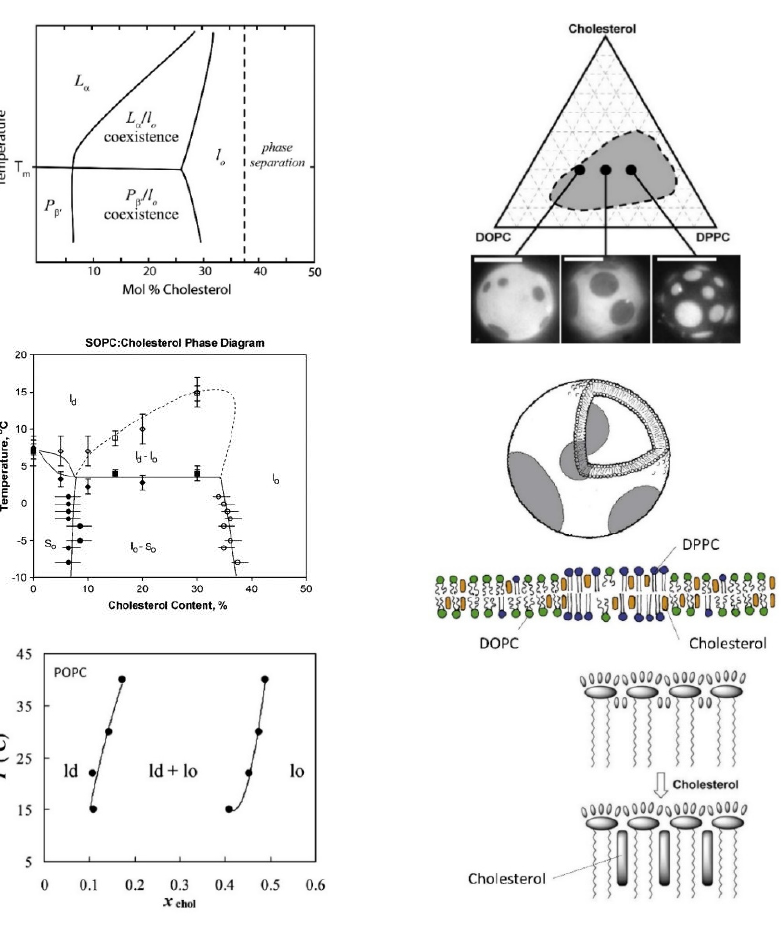
Figure 24. Domain formation in mixed aqueous phospholipid/cholesterol bilayers ( a ) Top : Generalized bilayer state diagram for bilayers of phosphatidylcholines and cholesterol as a function of cholesterol content and temperature, as published by Rheinstädter et al. (2013) [305]. Depending on the cholesterol content and the temperature, single states exist within the bilayer ( L α at T > T m , P β′ at T < T m , both at low cholesterol contents; l o at ~30–37 mol% cholesterol; or coexisting states are present ( L α and l o , or P β′ and l o ). At high levels of cholesterol, cholesterol separates as pure crystalline phase [305]. Middle : Elaborated diagram for illustrating the situation in the case of aqueous SOPC/choles- terol bilayers, as determined by differential scanning calorimetry/DSC) ( ♦ , ◊ ) proton magic angle spinning NMR ( ■ , □ ), and deuterium NMR ( ● , ○ ) measurements, as published by Polozov and Gawrisch (2006) [299]. SOPC is 1-stearoyl-2-oleoyl- sn -glycero-3-phosphocholine, T m (SOPC) = 6.9 ± 2.9 °C [101]. Bottom : Elaborated diagram for aqueous POPC/cholesterol bilayers, as determined from measurements of the steady state anisotropy of embedded DPH (1,6-diphenylhexatriene) and fluo- rescence lifetime measurements of t -PnA ( trans -parinaric acid), as published by de Almeida et al. (2003) [297]. ( b ) Top : Triangular representation of the domain formation in mixed DOPC/DPPC/cho- lesterol bilayers at T = 25 °C, determined by analyzing fluorescence micrographs using DPPE-Texas Red as fluorescent probe that partitions preferentially into less ordered, liquid domains; see Veatch et al. (2004) [298]. The GUVs shown were prepared by “electroformation” at 30% cholesterol and the following compositions (from left to right): DOPC/DPPC (2:1), DOPC/DPPC (1:1), and DOPC/DPPC (1:2) (bars: 20 μ m) [298]. Middle : Schematic drawing of unilamellar vesicle and illus- tration of two liquid states containing different fractions of the three lipid types; see Honerkamp- Smith et al. (2009) [302]. Bottom : Schematic model of the effect of cholesterol (long gray bars) on the presence of water molecules (small gray ellipsoids) near the phospholipid head groups forming the l o state within the bilayer; see M’Baye et al. (2008) [300]. Reproduced with permission from [305] Elsevier, 2013; from [299], Elsevier 2006; from [297], Elsevier, 2003; from [296], Elsevier, 2004; from [302], Elsevier, 2009; and from [300], Elsevier, 2008.